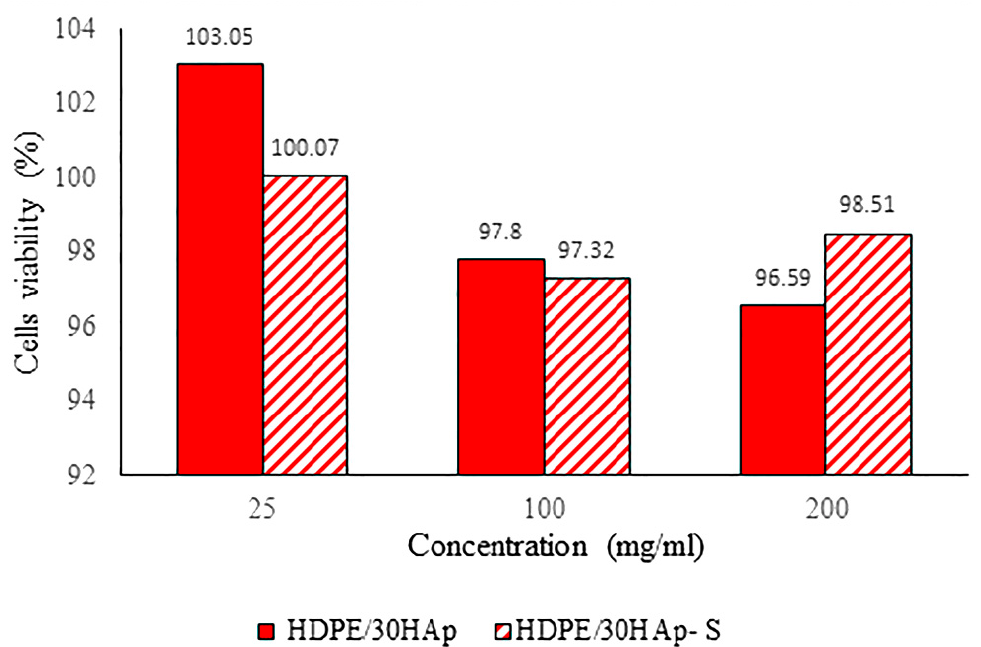
Figure 10. Percentage of cell viability at different concentrations for untreated HDPE/30HAp and treated HDPE/30HAp-S composites.